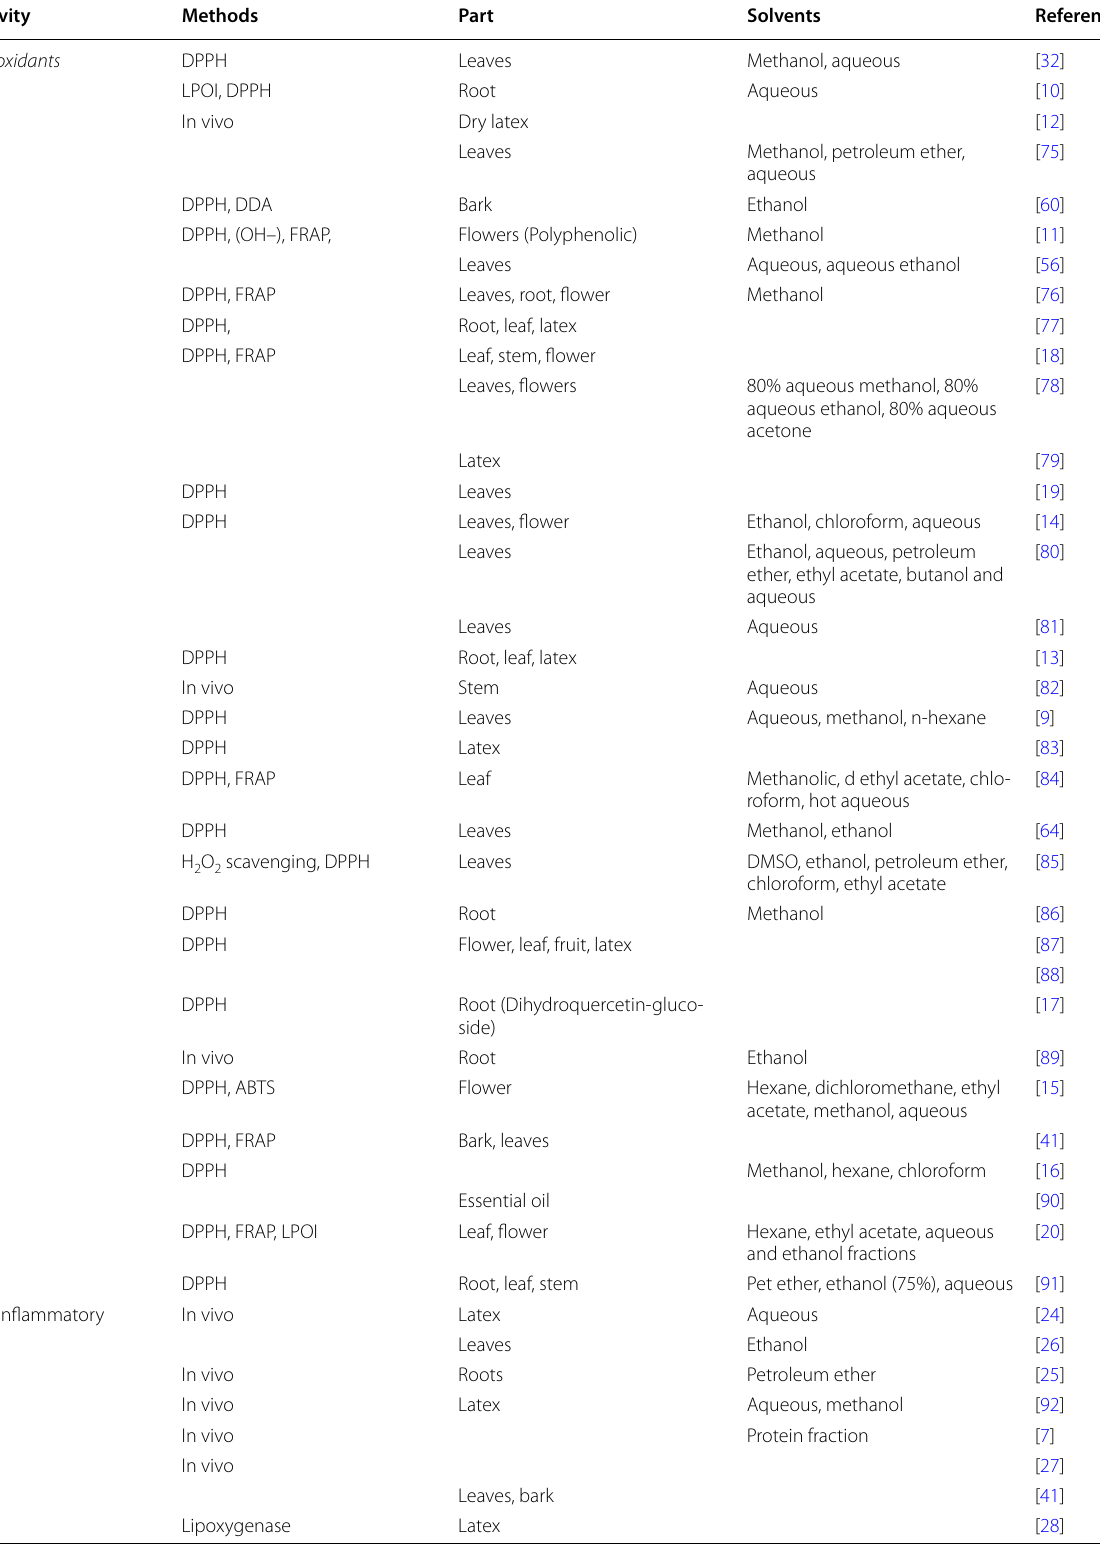
Table 1 Biological activity of C. procera S/N